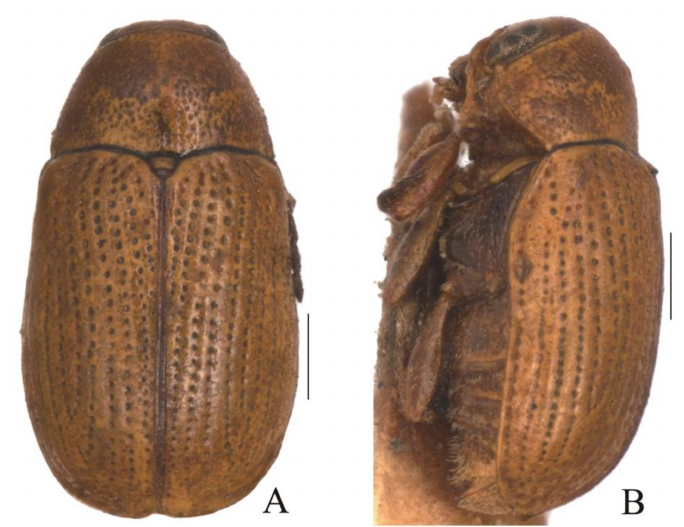
Figure 35. Cryptocephalus ( Burlinius ) turpis Chen, 1942: ( A ) habitus; ( B ) lateral view of habitus (Scale bars: 0.5 mm) (paratype, female).